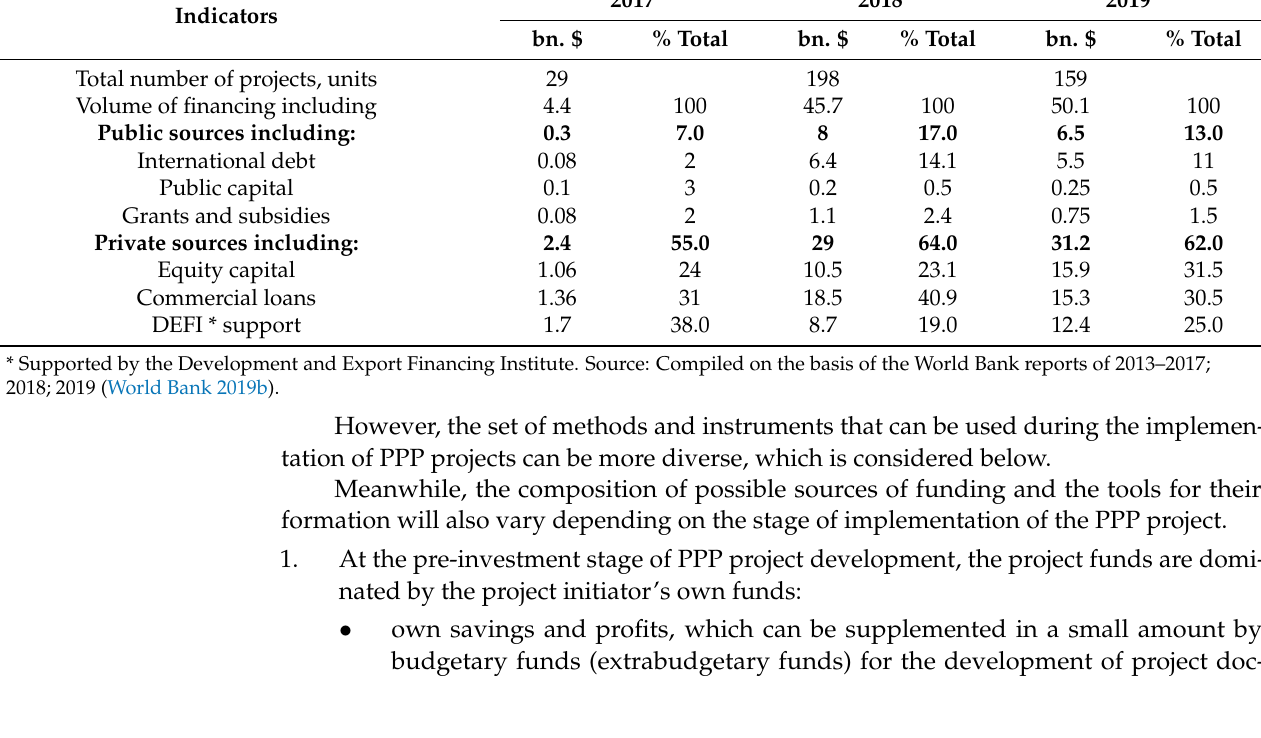
Table 5. Composition and structure of private-sector infrastructure financing (according to the World Bank data).